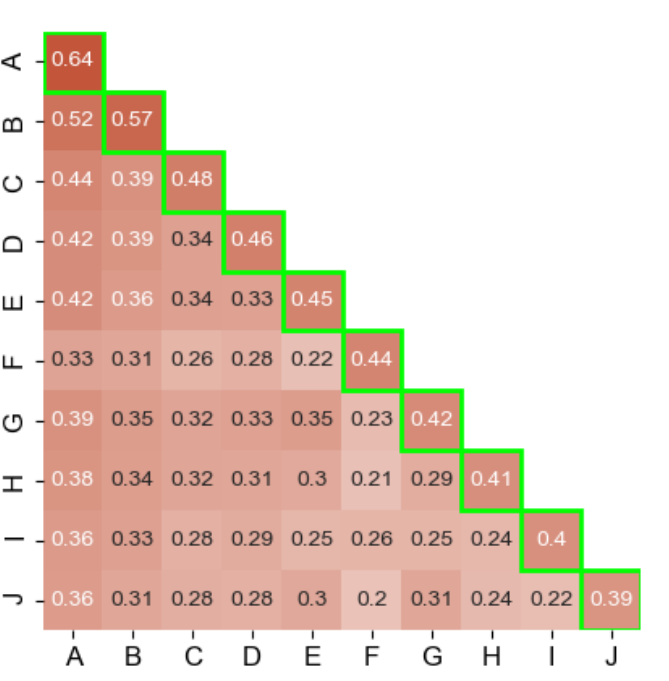
Figure 2. Heatmap for the top 10 engines in coverage. ( A ): eset-nod32, ( B ): ikarus, ( C ): fortinet, ( D ): cat-quickheal, ( E ): nano-antivirus, ( F ): symantecmobileinsight, ( G ): avira, ( H ): cyren, ( I ): k7gw, ( J ): F-secure. The cells with the light green edges are those that represent the single coverage for the